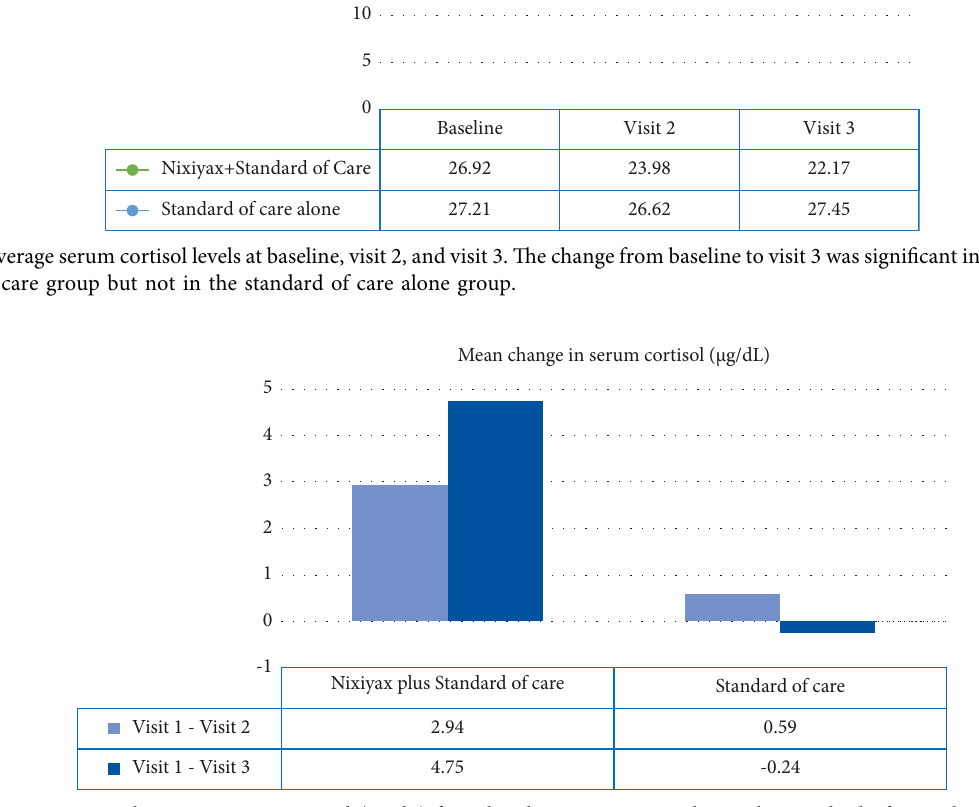
Figure 3: Mean change in serum cortisol ( μ g/dL) from baseline to visits 2 and 3 in the standard of care alone